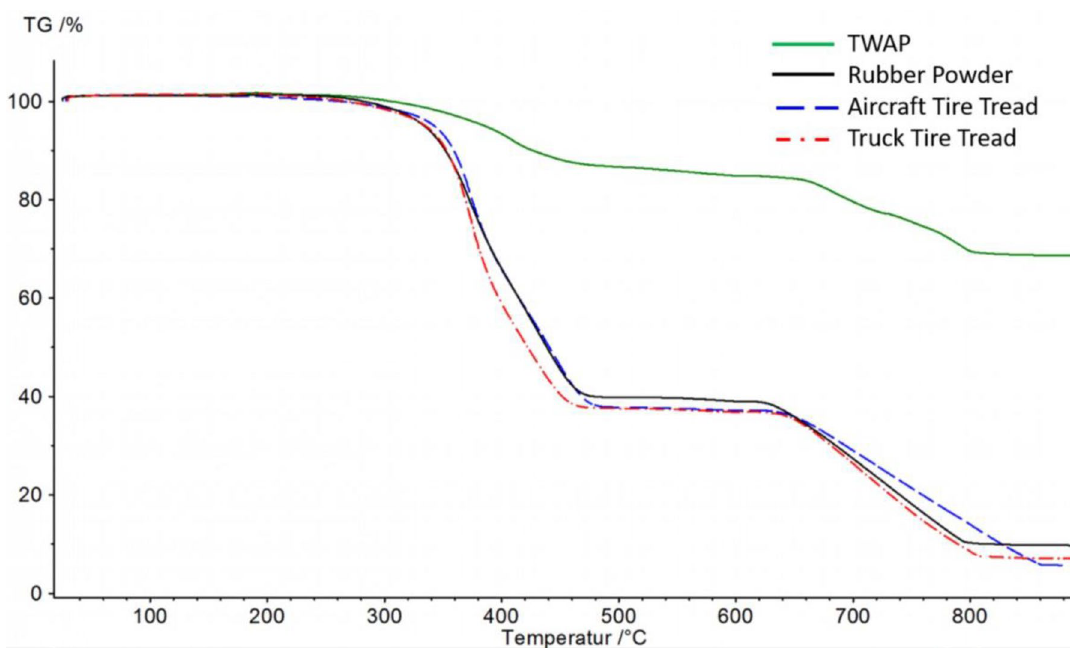
Figure 4. Comparison of TGA-Analyses for TWAP, rubber powder, aircraft and truck tire tread.